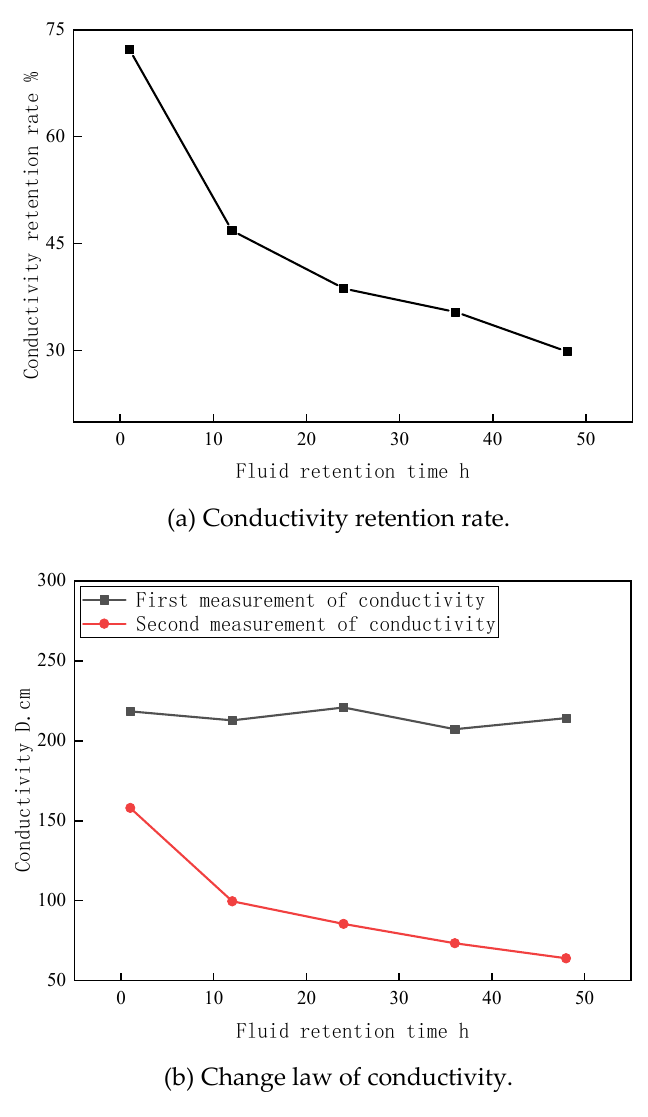
Figure 4. Influence of fluid retention time on conductivity.